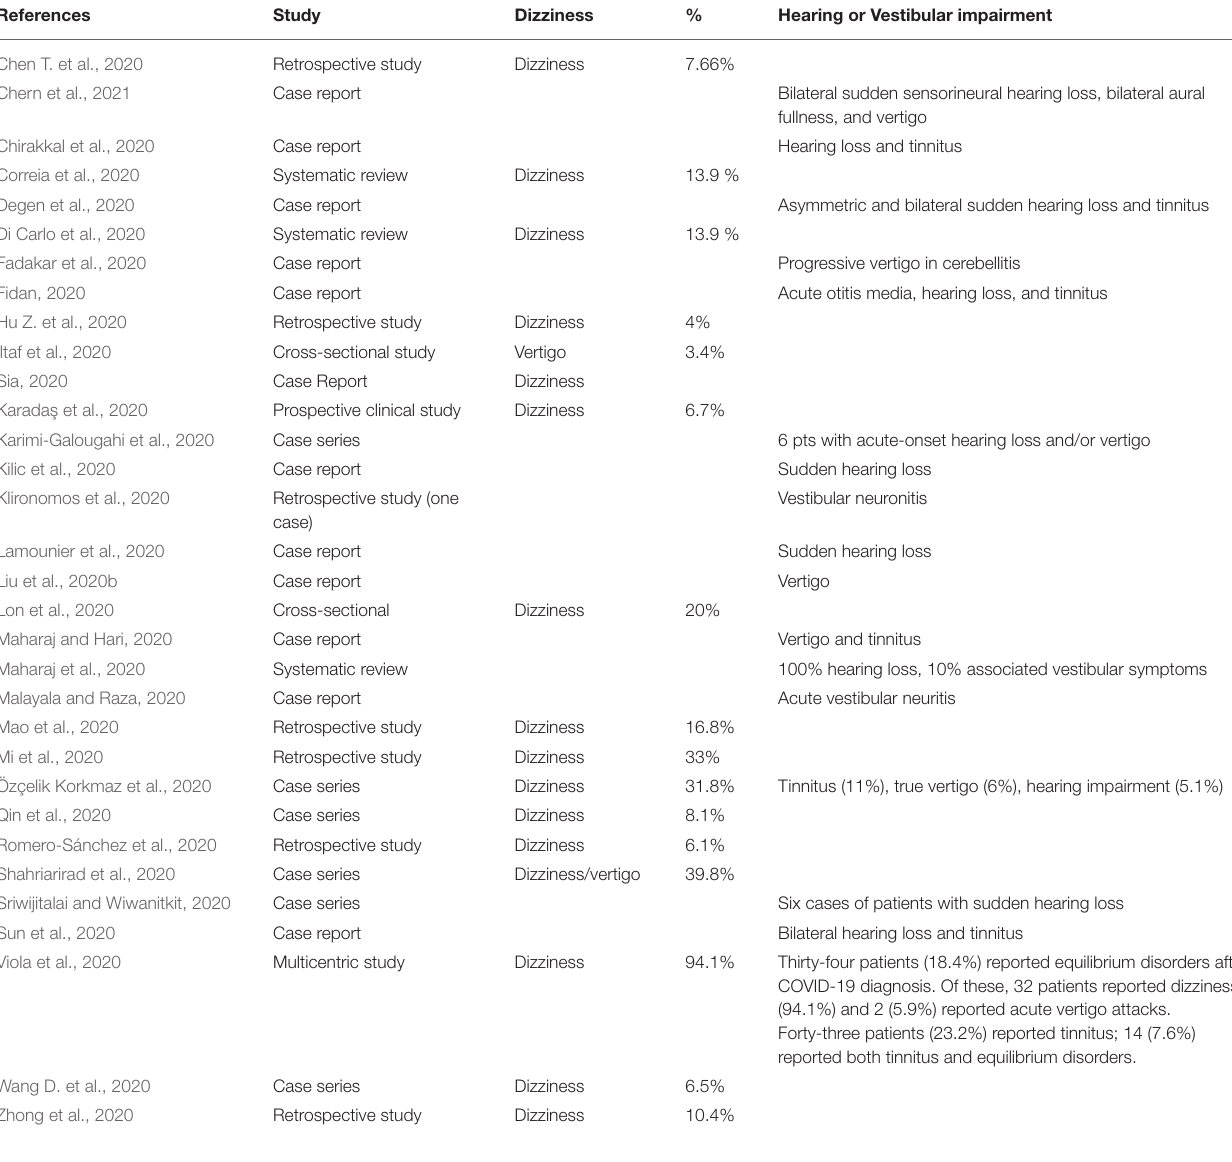
TABLE 2 | Dizziness as clinical onset symptom reported in